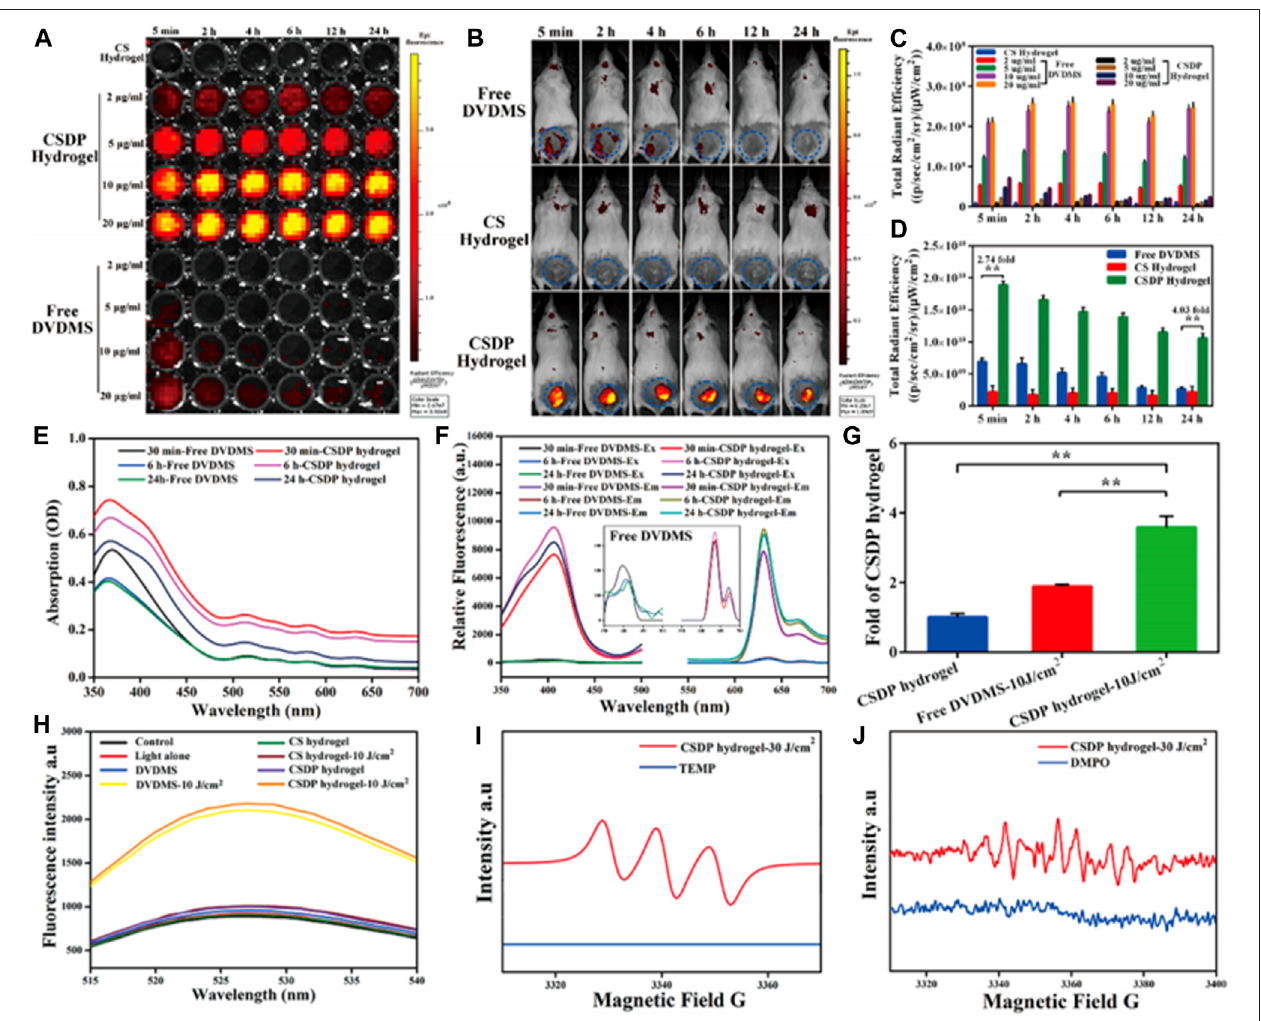
FIGURE 8 | Fluorescence imaging of the hydrogel via 96 well-plates (A) and in vivo mice models (B) . The fi gures showed the emittance of fl uorescence from the hydrogel loaded with an imaging agent and PACT. The in vitro results were reproduced in tests done in animals through the mice model showing the translational potential of the system. (C , D) quantitative analysis of the fl uorescence imaging in vitro and in vivo , respectively. Absorbance (E) and fl uorescence spectra (F) of nanosysten, hydrogelloadedwiththenanospheres. (G) Singlet oxygen yieldsofhydrogel, freenanospheres, and hydrogel-loadednanospheres asdetermined via a fl uorescence spectrophotometer. (H) SOSGspectraofdifferent groups. (I , J) Detection offreeradicalsviaESR spectraand single oxygen species generationfrom the hydrogel in the dark and light irradiation, respectively. From the results, the hydrogel formulation was determined to be superior to the free systems. Reproduced with permission from Mai et al.